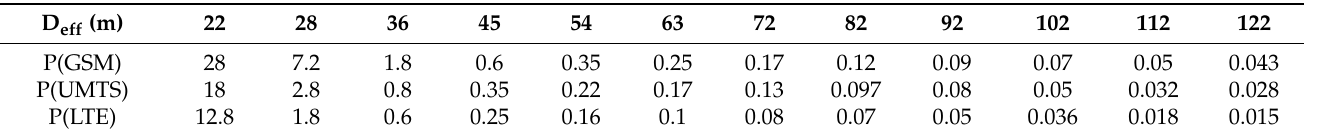
Table 1. Measured received powers as a function of distance from the mobile communication antenna relay for the three selected networks (GSM-1800, UMTS-2100 and LTE-2.6) in mW.